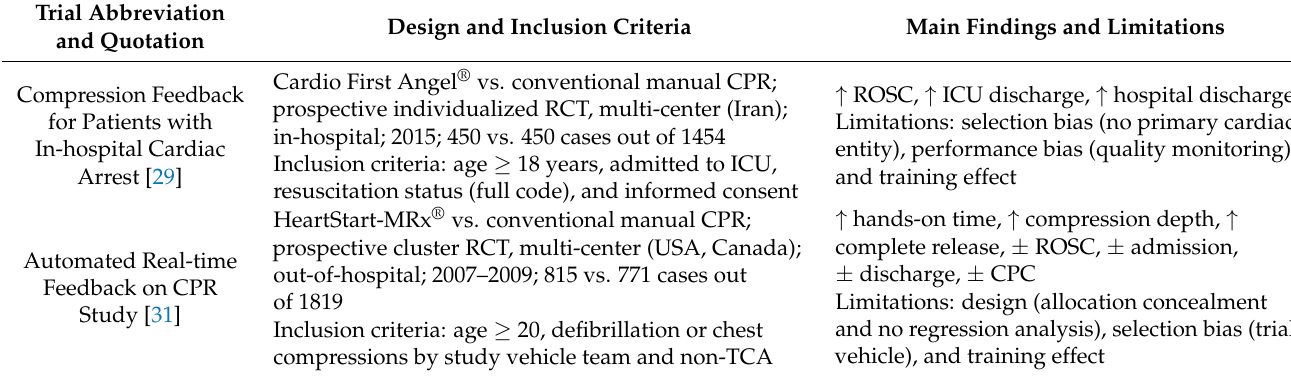
Table 1. Overview of RCTs on real-time audio or audiovisual CPR feedback systems vs. conventional manual chest